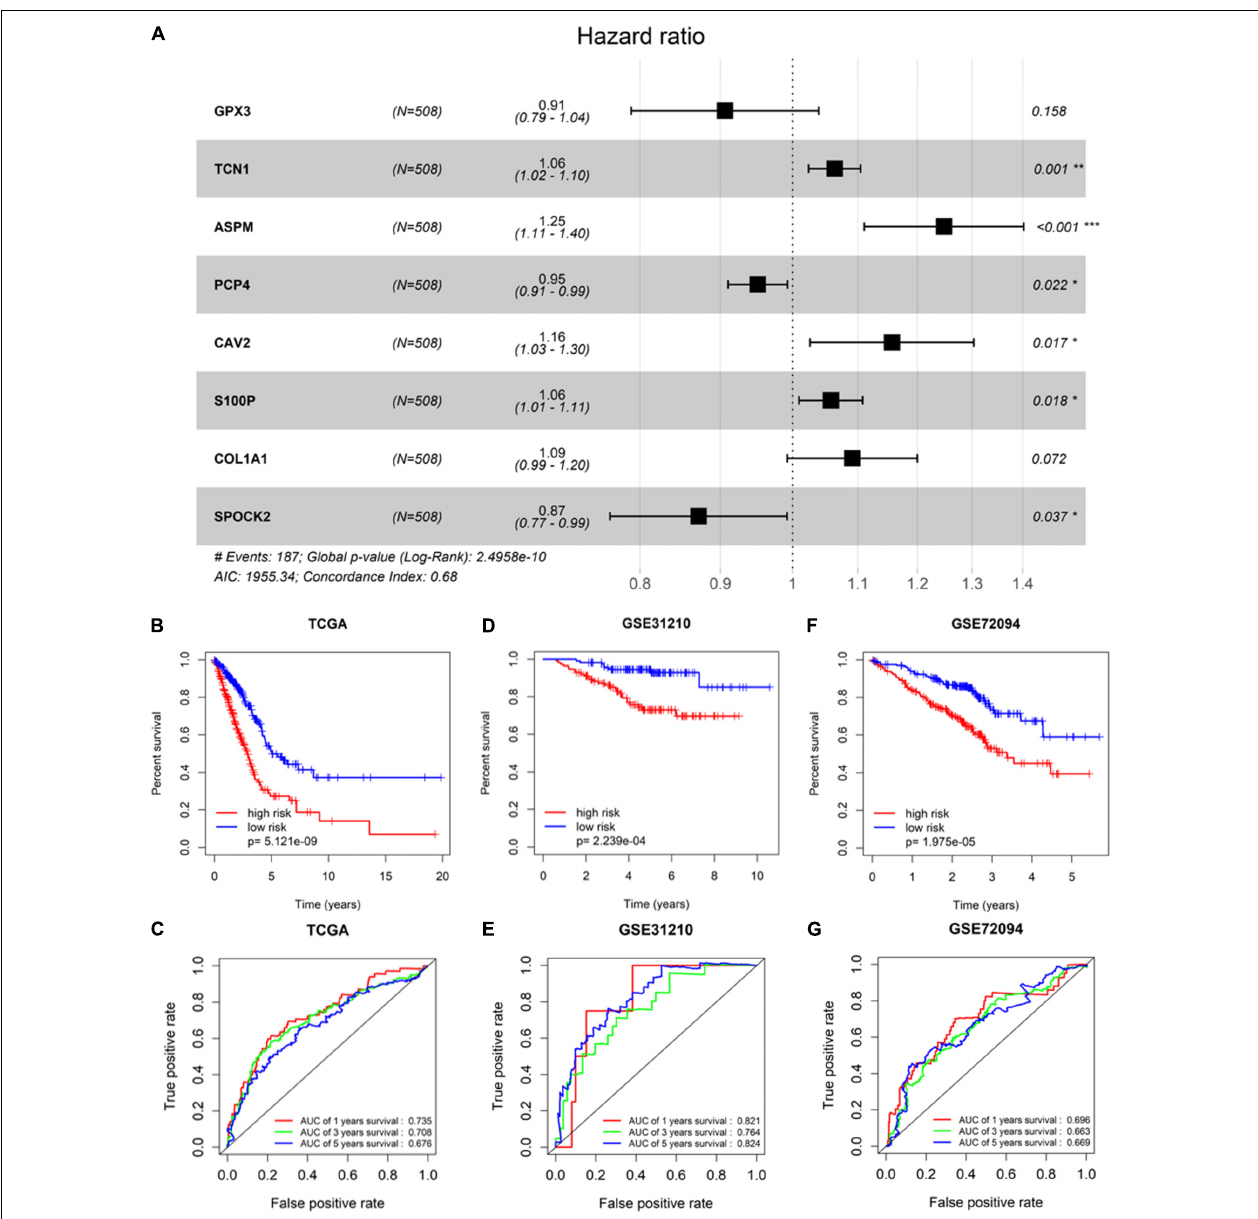
FIGURE 5 | Validation of prognostic risk model. (A) Gene signature filtered by multivariate Cox regression analysis; (B,D,F) Kaplan–Meier survival curve analysis in TCGA-LUAD cohort, GSE31210, and GSE72094, respectively (patients were grouped by the median risk score); (C,E,G) ROC analysis of the sensitivity and specificity of the OS for the eight-gene risk score in TCGA-LUAD, GSE31210, and GSE72094, respectively. * Represents p-value < 0.05, ** represents p-value < 0.01, *** represents p-value < 0.001, and # represents annotation